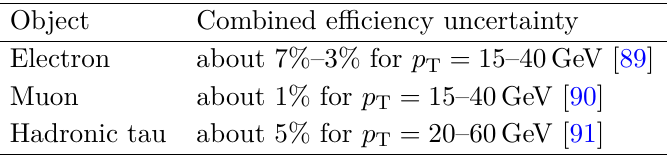
Table 2 . The combined efficiency uncertainty (reconstruction and identification) of the final ob-